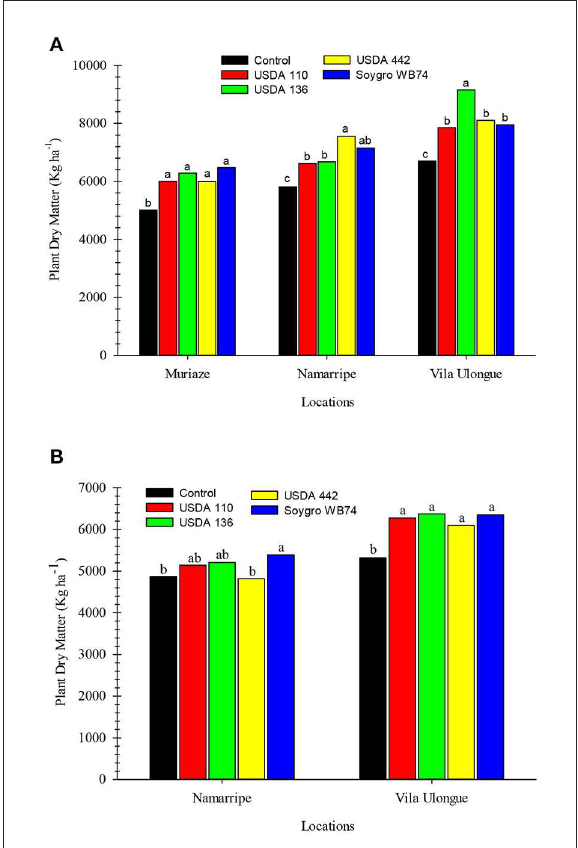
FIGURE4 Dry matter yield of soybean inoculated with various inoculant strains in 2018 (A) and 2019 (B) in Mozambique. Means within a location followed by the same letter are not significantly different at P < 0.05 according to